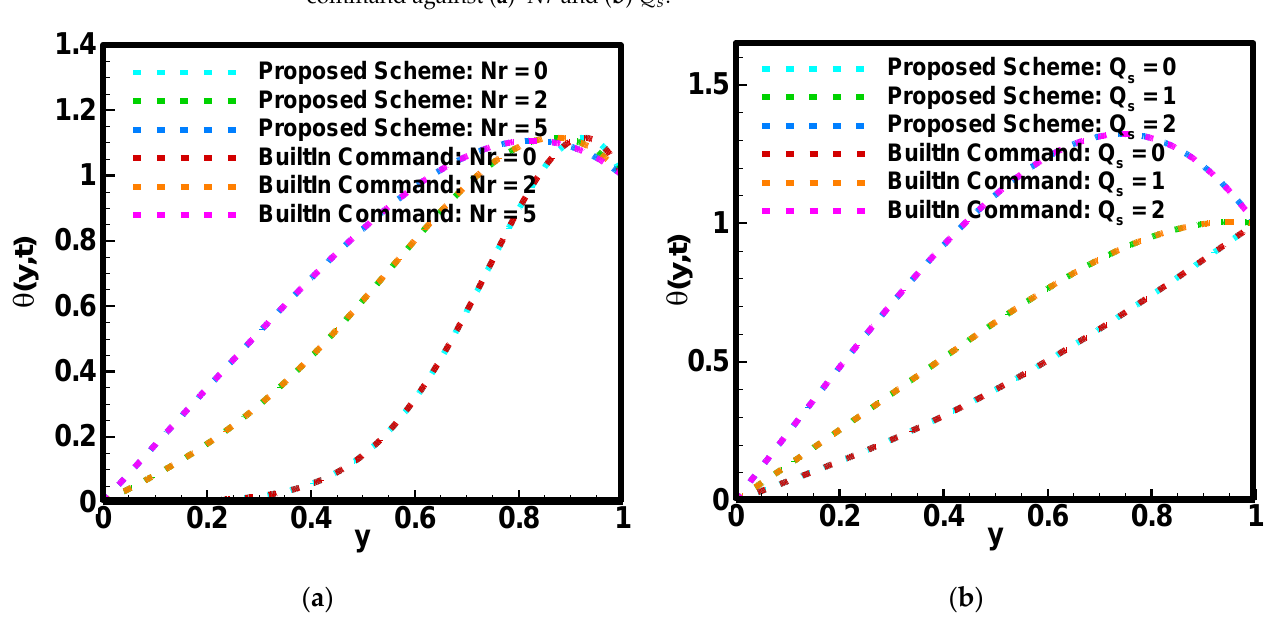
Figure 15. Comparison of dimensionless temperature between Proposed Method and Maple Built-in command against ( a ) 𝑁𝑟 and ( b ) 𝑄 𝑠 .